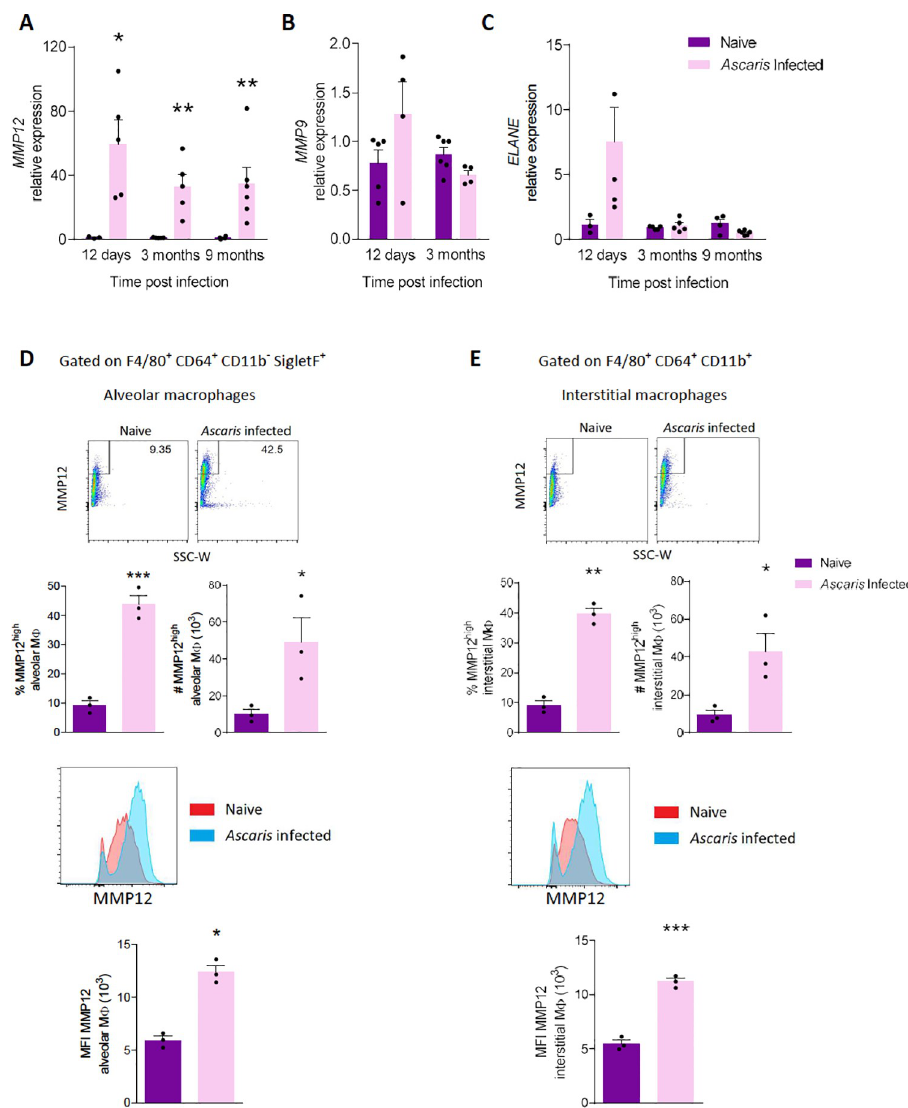
Fig 3. Matrix Metalloprotease (MMP)-12 is chronically upregulated in alveolar and interstitial macrophages (M F ) by Ascaris . (A-C) mRNA level of (A) MMP12, (B) MMP9, and (C) neutrophil elastase (ELANE) from Ascaris infected and na ï ve mice post infection. (D-F) Flow cytometry analysis on F4/80 + CD64 + CD11b - SigletF + Alveolar macrophages and F4/80 + CD64 + CD11b + interstitial macrophages (D) Representative flow plot of MMP12 on alveolar macrophages and the aggregate data of MMP12 high alveolar macrophages expressed as percentages and absolute cell numbers and representative histograms and median fluorescence intensity (MFI) of MMP12 data are shown. (E) Representative flow plot of MMP12 on interstitial macrophages and the aggregate data of MMP12 high interstitial macrophages expressed as percentages and absolute cell numbers and representative histograms and median fluorescence intensity (MFI) of MMP12 data are shown. (n � 3, mean ± S.E.M, n.s.: not significant, � p < 0.05, �� p < 0.01, ��� p < 0.001, using two tailed Student’s t-test. Data are representative of two independent experiments) The presence of hemosiderin-laden macrophages in both lung tissue and BALF over time signaled the likelihood of chronic pulmonary vascular damage in Ascaris -infected mice, which was supported by the presence of erythrocytes within alveoli as long as 9 months p.i. (S3 Fig). As acute Ascaris larval migration involves larvae traversing the vascular wall into the alveoli, we next determined vascular permeability after larval clearance. First, we quantified